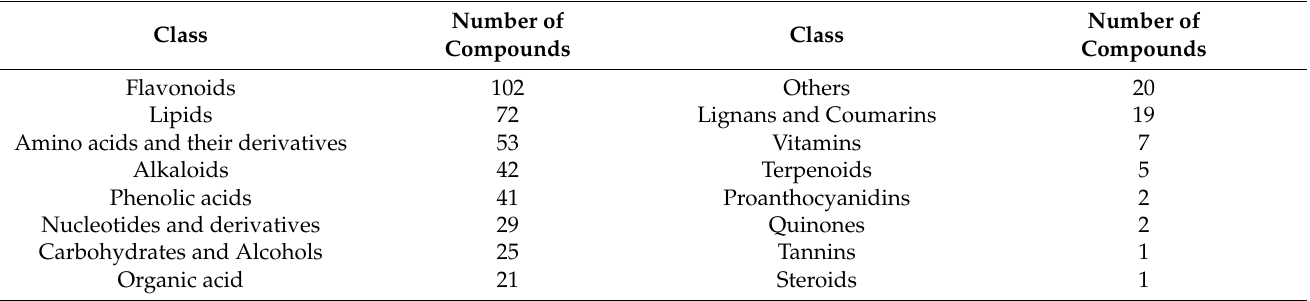
Table 2. Classification of the 442 detected metabolites in D. officinale stems from three